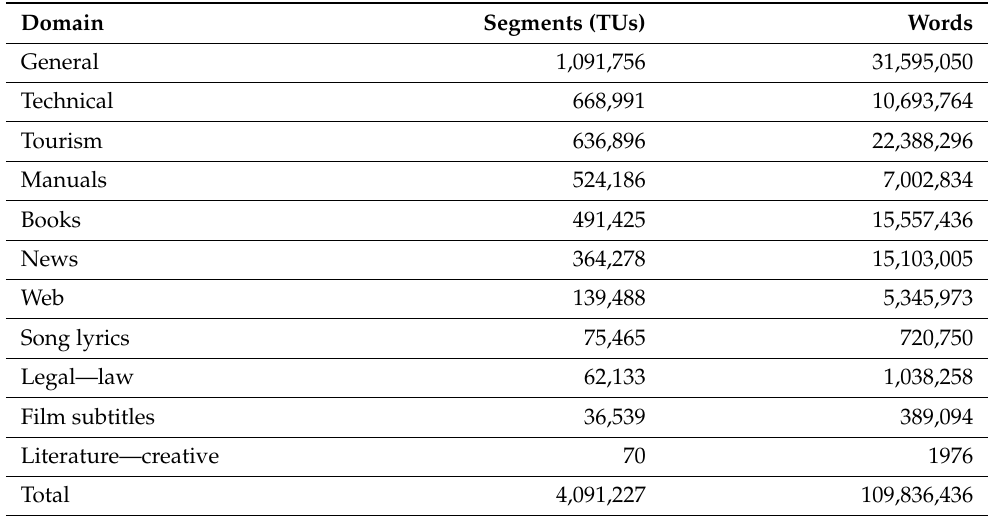
Table 2. Collected corpus—broken down by